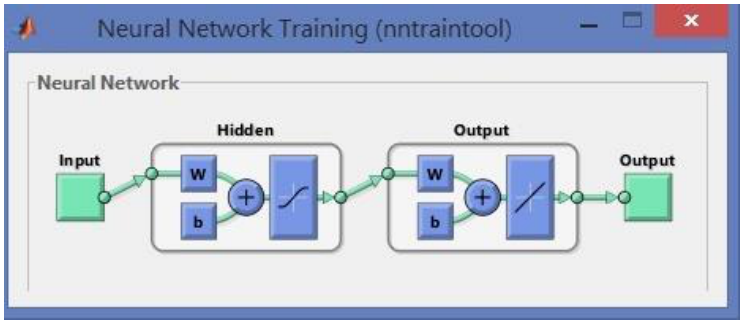
Figure 7. NN layout using the GUI toolbox in MATLAB.